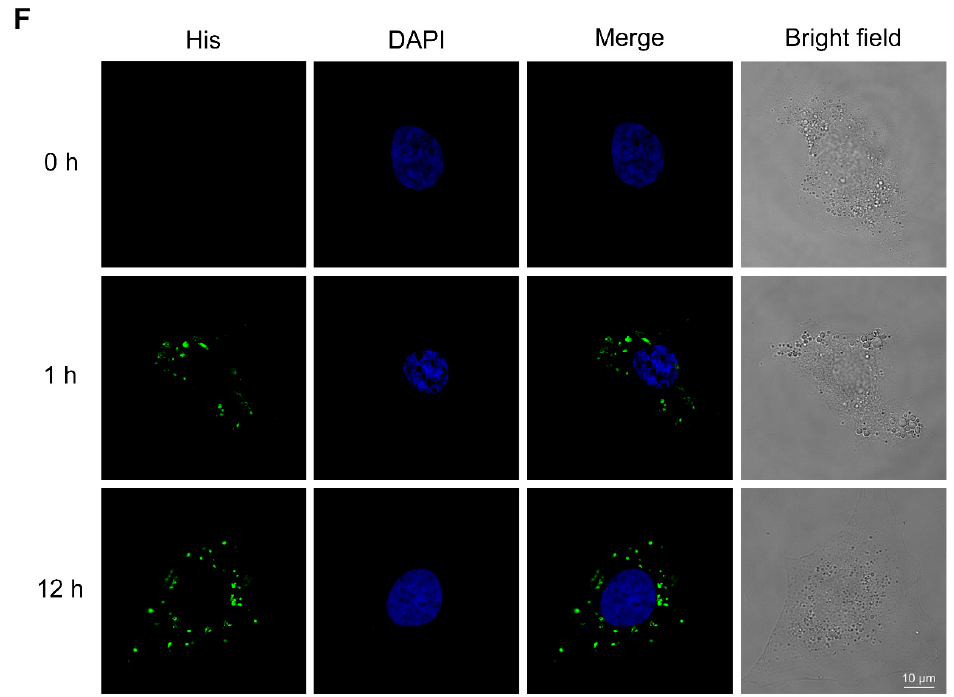
Figure 3. BmKDfsin3 inhibits p38 activation. ( A – C ) BmKDfsin3 suppresses p38 phosphorylation